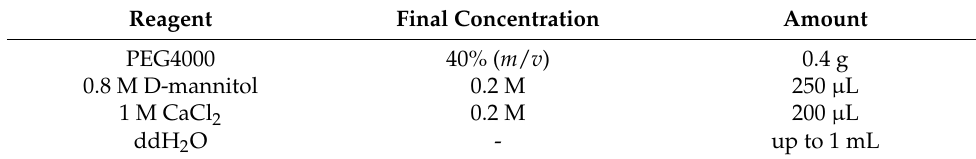
Table 5. Composition of 40% PEG solution (1